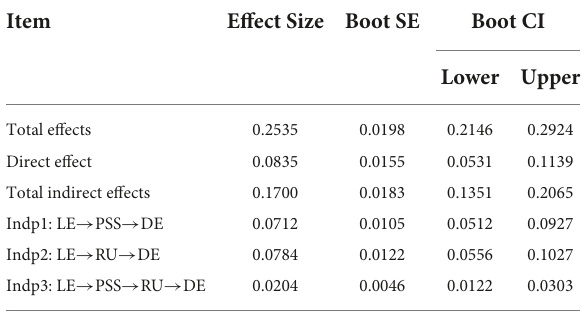
TABLE 4 Mediating effect test of perceived social support and